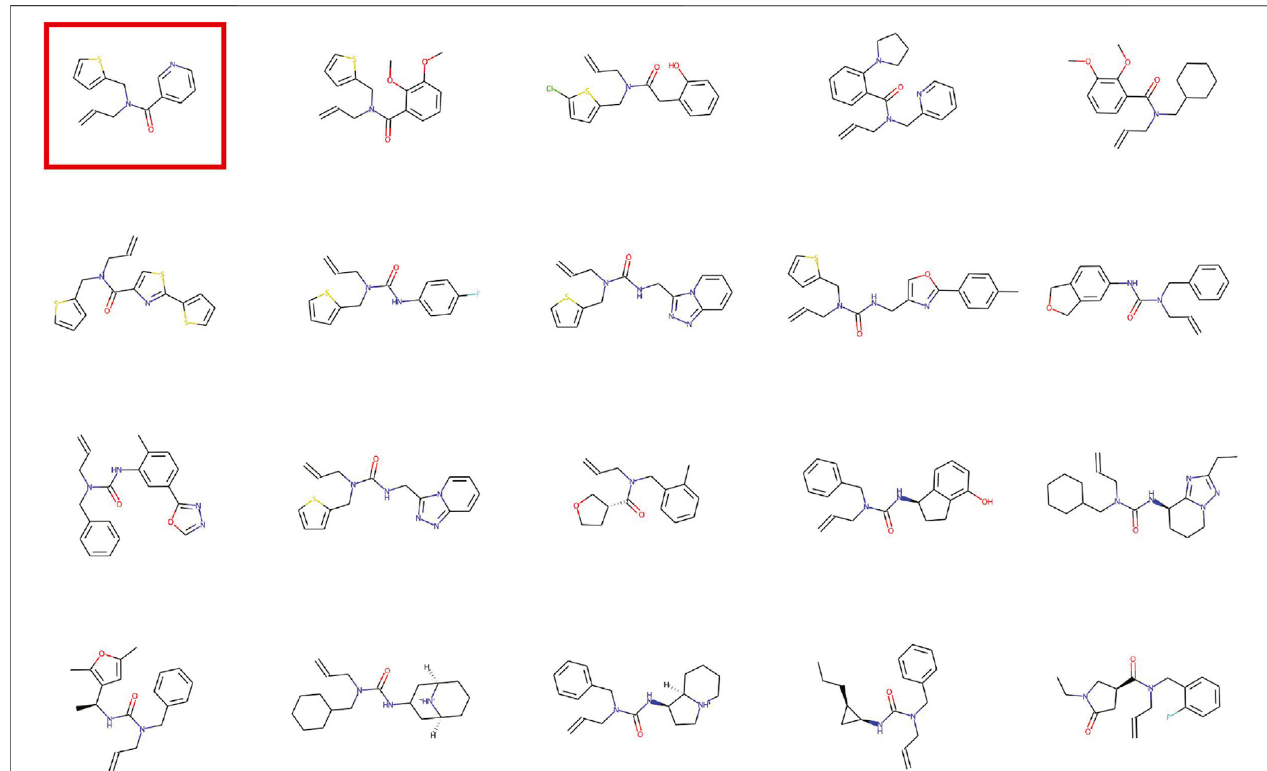
FIGURE 5 | Visualization of the latent space for molecular generation by a given molecule. The red circled molecule is the given molecule.